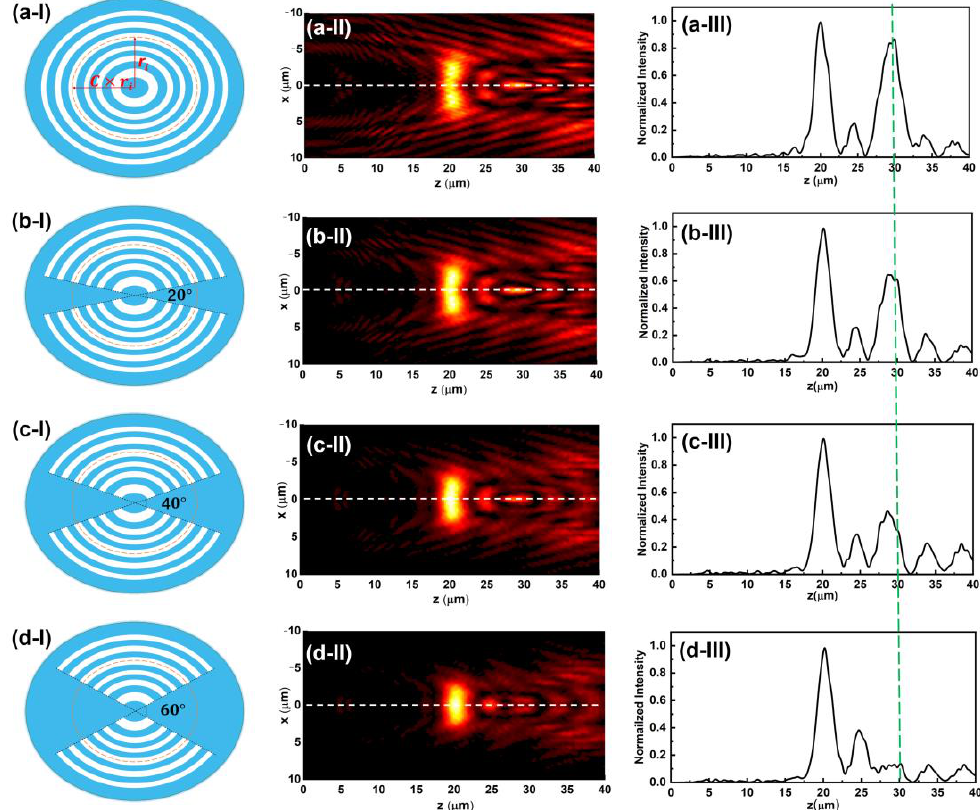
Figure 2. Comparison of light field distribution between elliptical SCL with different sector-shape cutting. ( a-I , b-I , c-I , d-I ) Scheme of the elliptical supercritical lens with cutting apex angle of 0 deg, 20 deg, 40 deg, and 60 deg, respectively; ( a-II , b-II , c-II , d-II ) the field distribution in the x - z plane with apex angle of the sector shape from 0 deg to 60 deg; ( a-III , b-III , c-III , d-III ) normalized intensity profiles along the optical axis for the corresponding elliptical SCL with different cutting sector. As the green dash line shows, the subsidiary focusing effect can be significantly suppressed while the apex angle of the sector-shape cutting region increases from 0 deg to 60